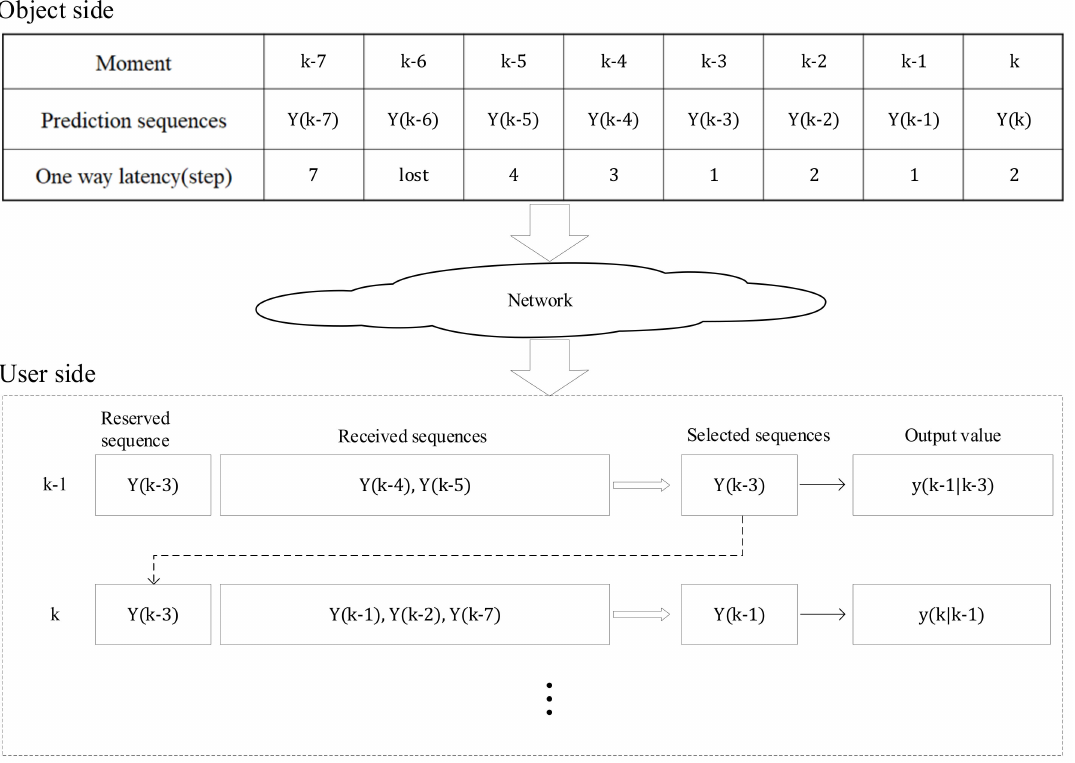
Figure 12. Scheme of the data selection at user